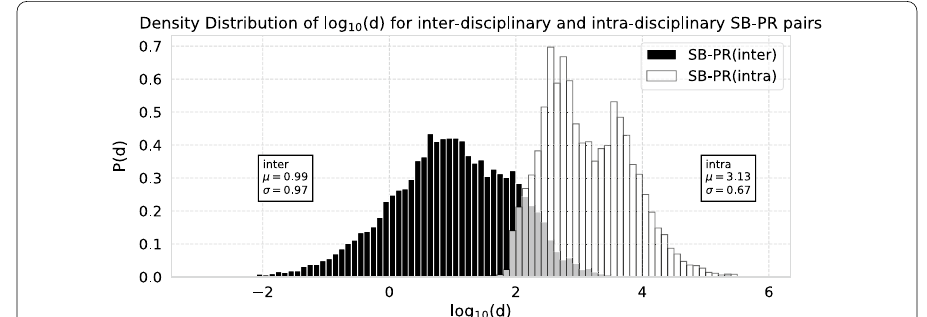
Fig. 13 Density distribution of d for inter-disciplinary and intra-disciplinary at the time of their citation